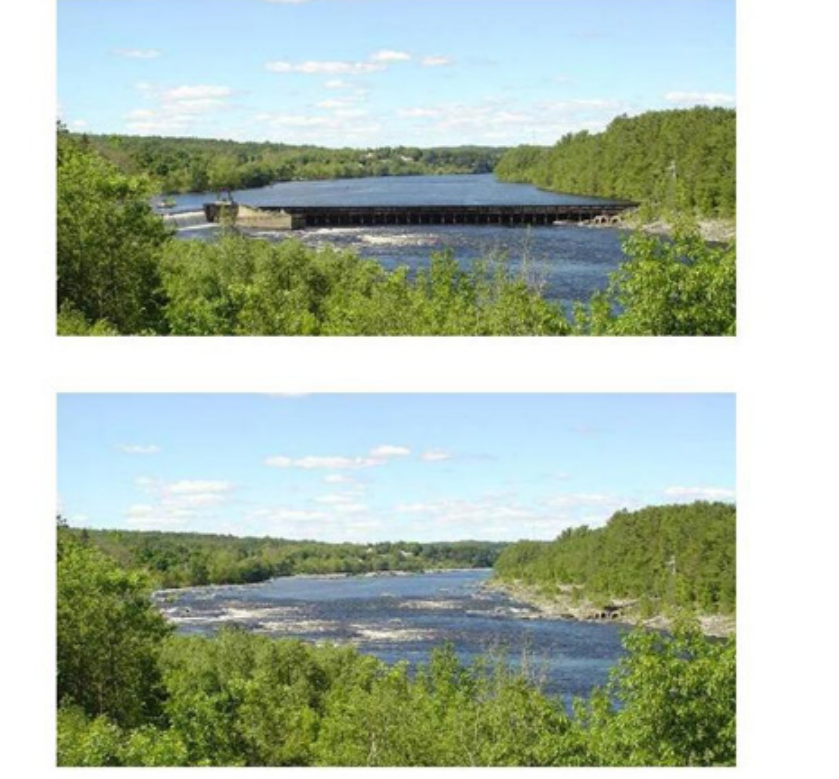
Fig. 2. A visualization of dam removal (Veazie Dam) that was used for public outreach and fundraising (images provided by MMI Engineering courtesy of the Penobscot River Restoration